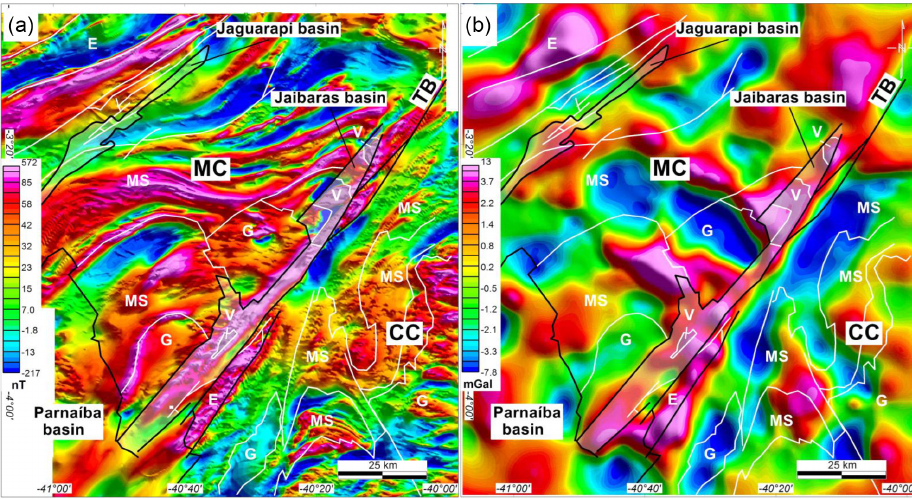
Figure 6. Residual reduced-to-pole magnetic (a) and gravity (b) anomaly maps of the Jaibaras basin. Geological contacts were extracted from Cavalcante et al. (2003). Tectonic domains: MC – Médio Coreaú; CC – Ceará Central. Geological units: E – granulites and eclogites; G – granites; MS – low-grade metasedimentary units; V – volcanic rocks. TB – Transbrasiliano